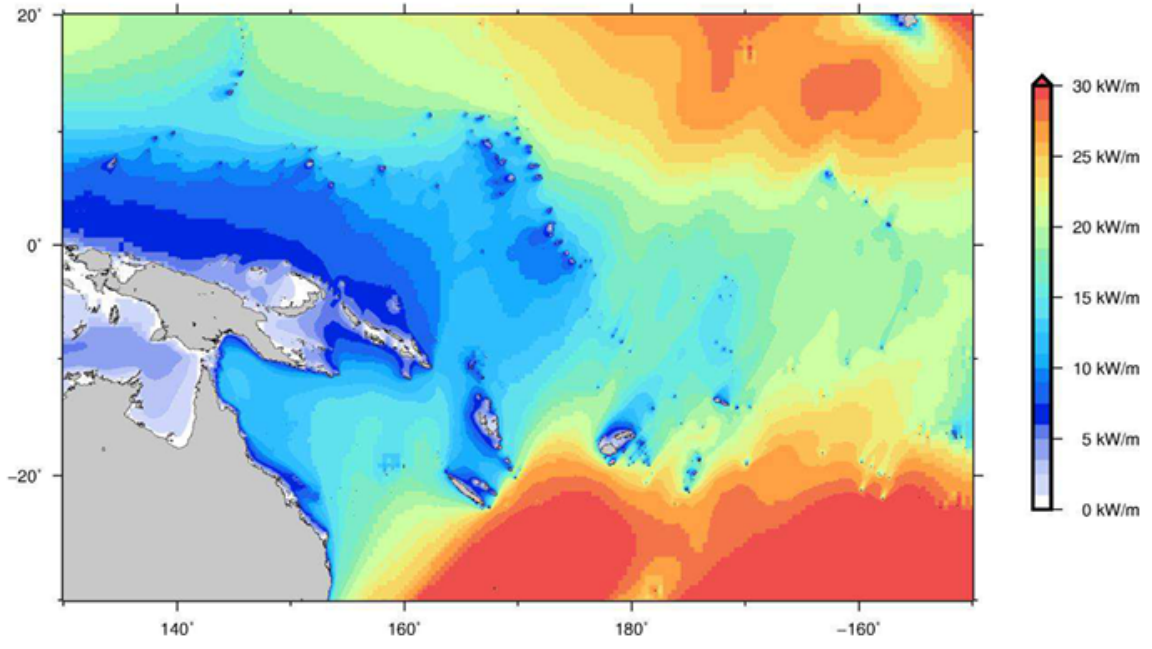
Figure 1. Average wave power in the Pacific (kW/m): reproduced from [2], Waves and Coasts in the Pacific, published by Pacific Community (SPC) 2015.